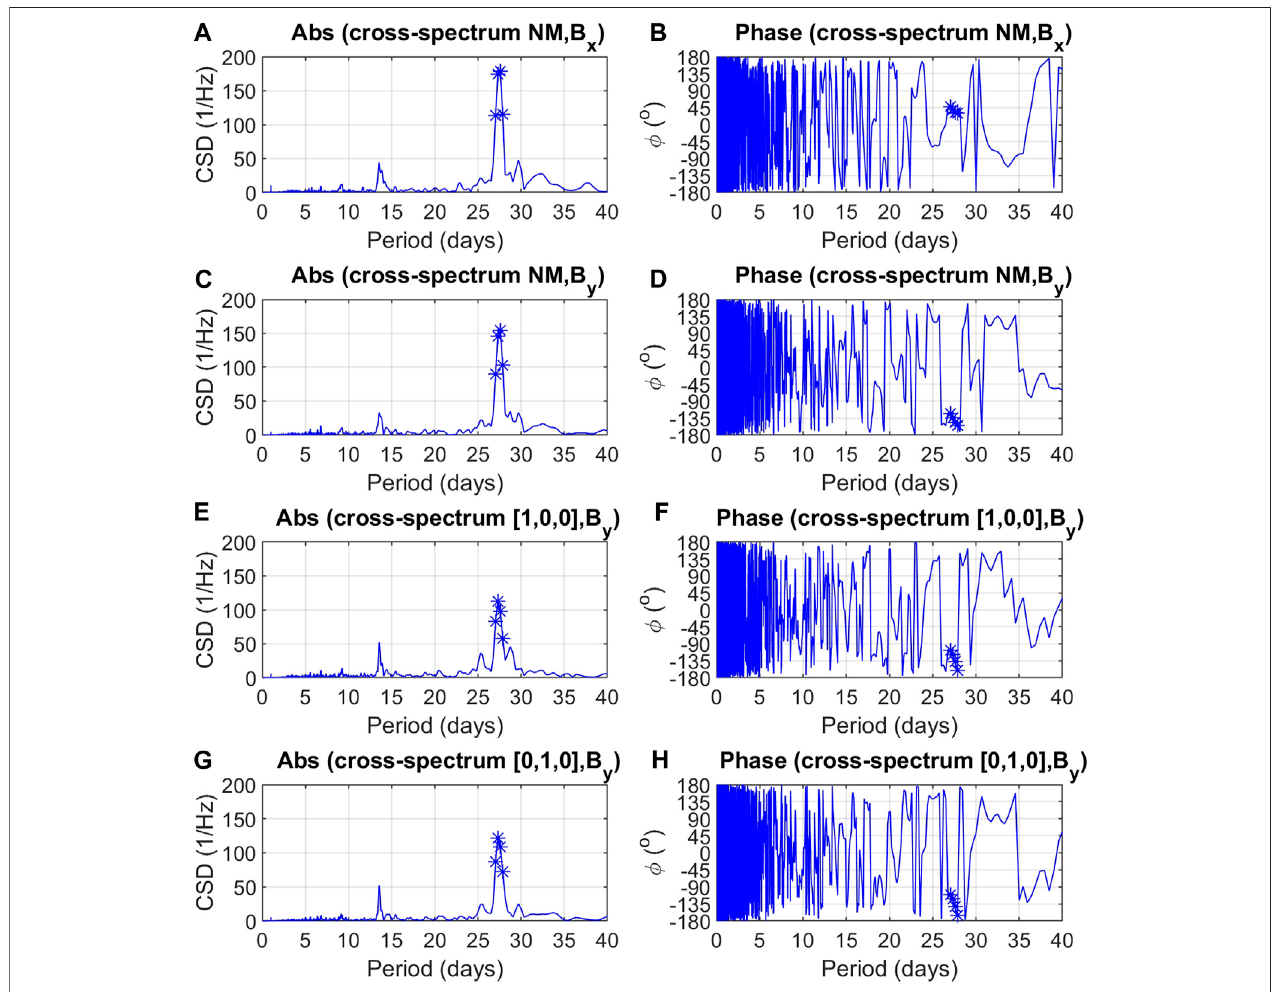
FIGURE 9 | Cross-spectral densities (absolute values and phase differences) of (A, B) normalized pressure-corrected NM counts and Bx , (C, D) normalized pressure-corrected NM counts and B y , (E, F) normalized pressure-corrected SEVAN [1,0,0] counts and B y , and (G, H) normalized pressure-corrected SEVAN [0,1,0] counts and B y . Asterisks mark the peak of absolute values of CSD, including its fl anks, and the corresponding phase difference.